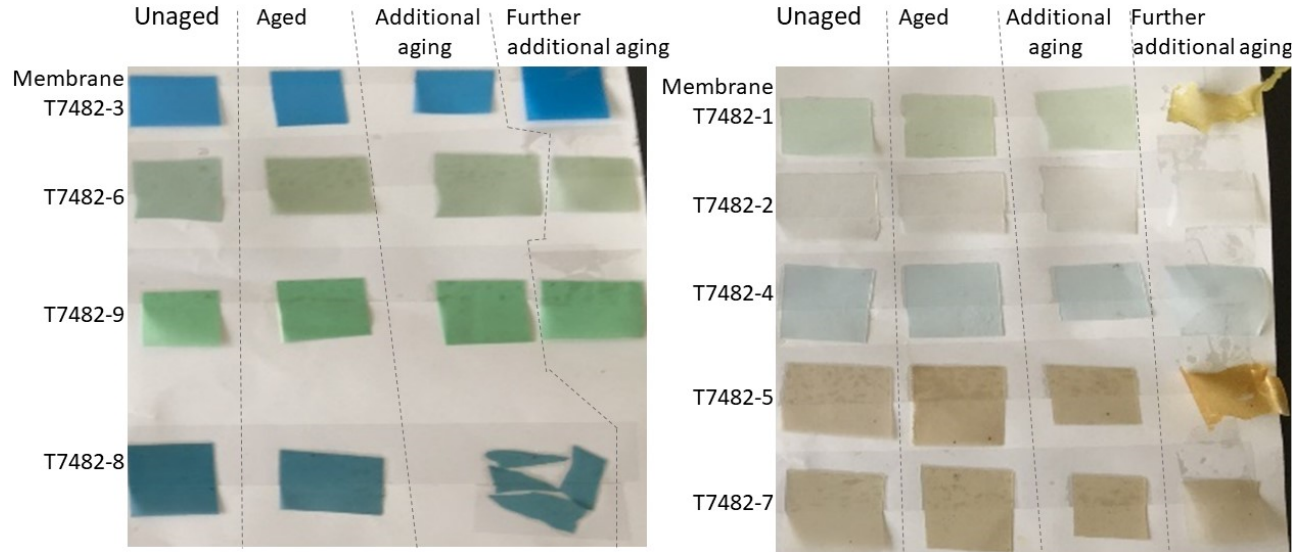
Figure 13. Membranes that showed measurable changes in chemical stability. Membrane T7482-8 showed significant chemical changes after additional aging of 50 days (in total 218 days). Furthermore, T7482-1 and T7482-5 showed significant chemical changes after further additional aging of 30 days (in total 248 days).